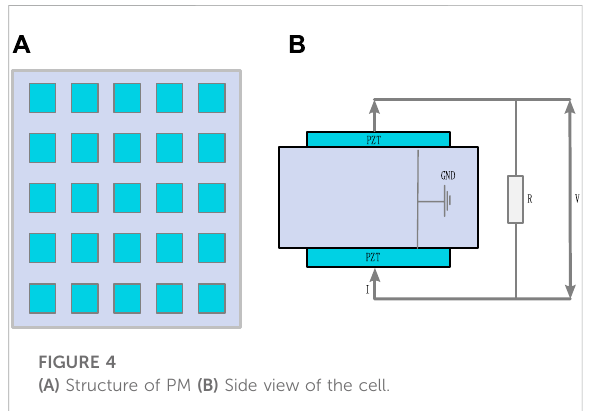
FIGURE 4 (A) Structure of PM (B) Side view of the